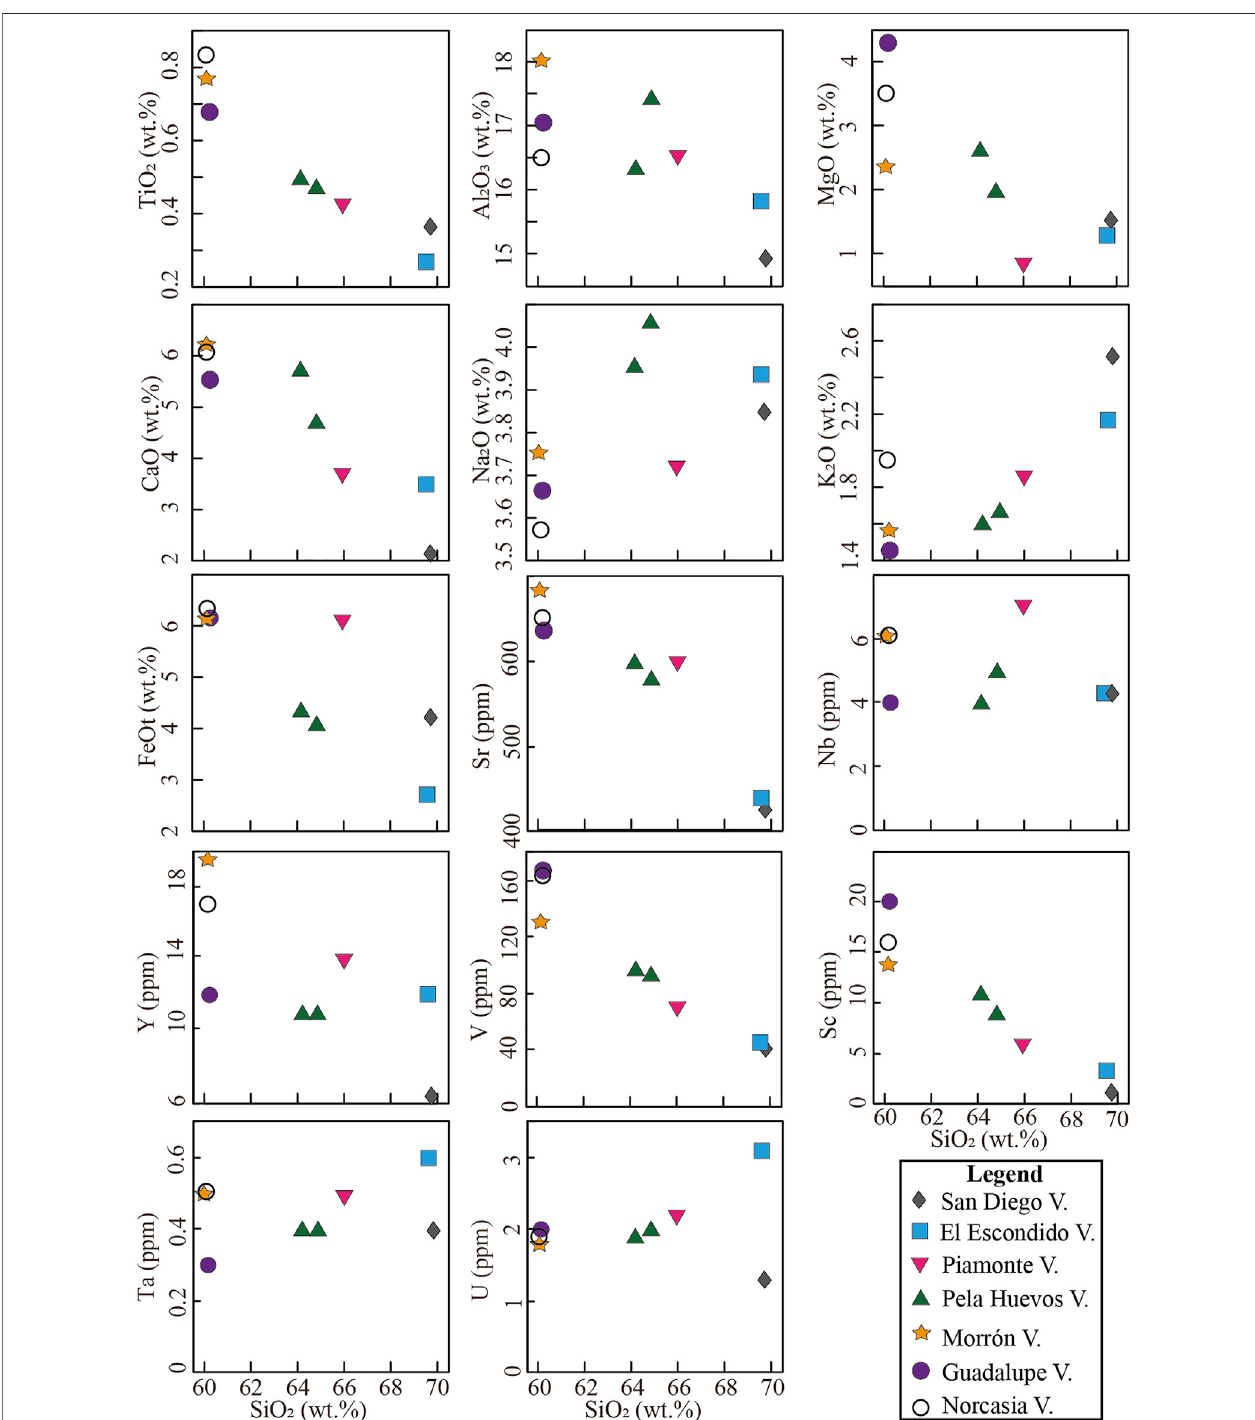
FIGURE 7 | SiO 2 vs. major and trace elements diagrams. Note the af fi nity shared by the volcanoes based on the silica content.